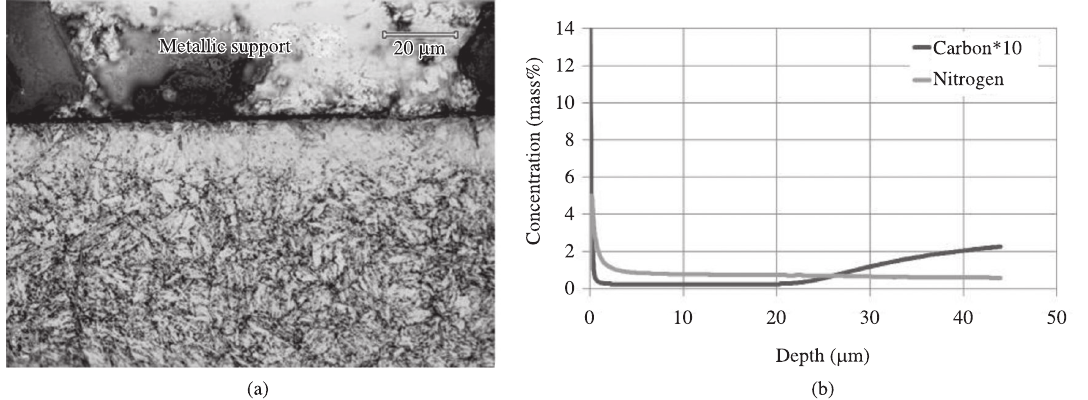
Figure 6. Sample 5N -2h. In (a) photomicrography of the cross section of the sample and in (b) GDOES profile. 2